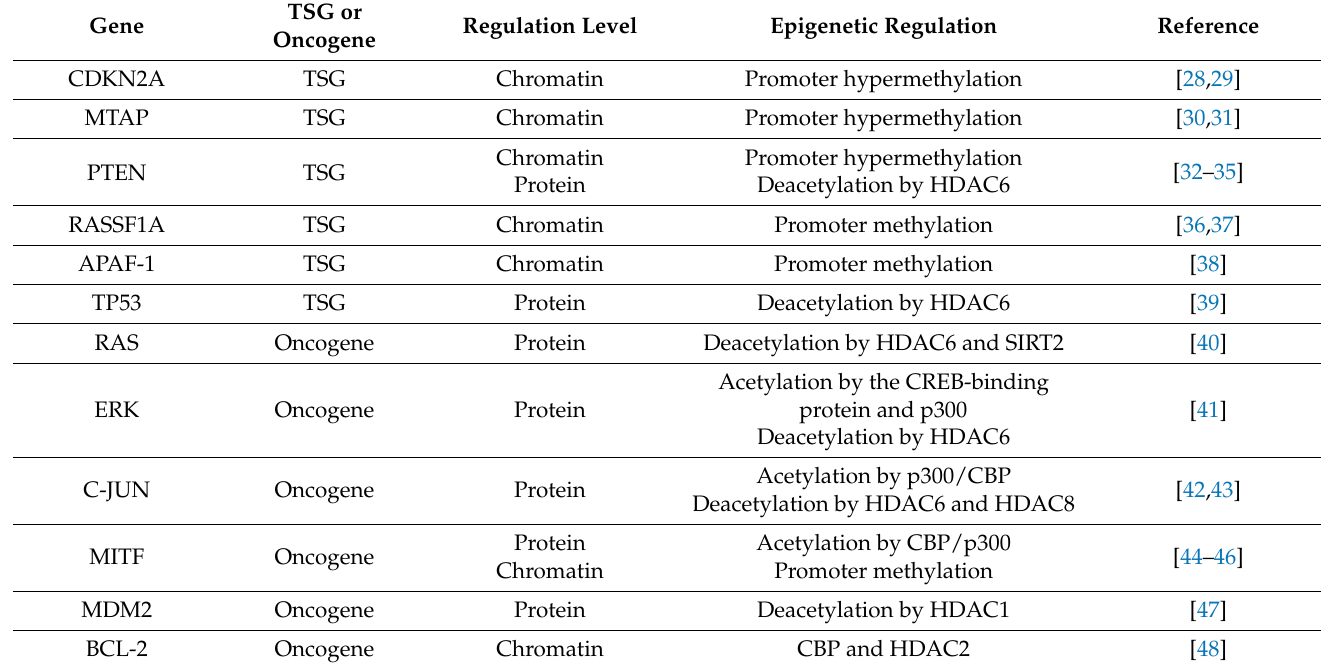
Table 1. Epigenetic modifiers regulate the tumor suppressor genes (TSGs) and oncogenes important for melanoma progression.